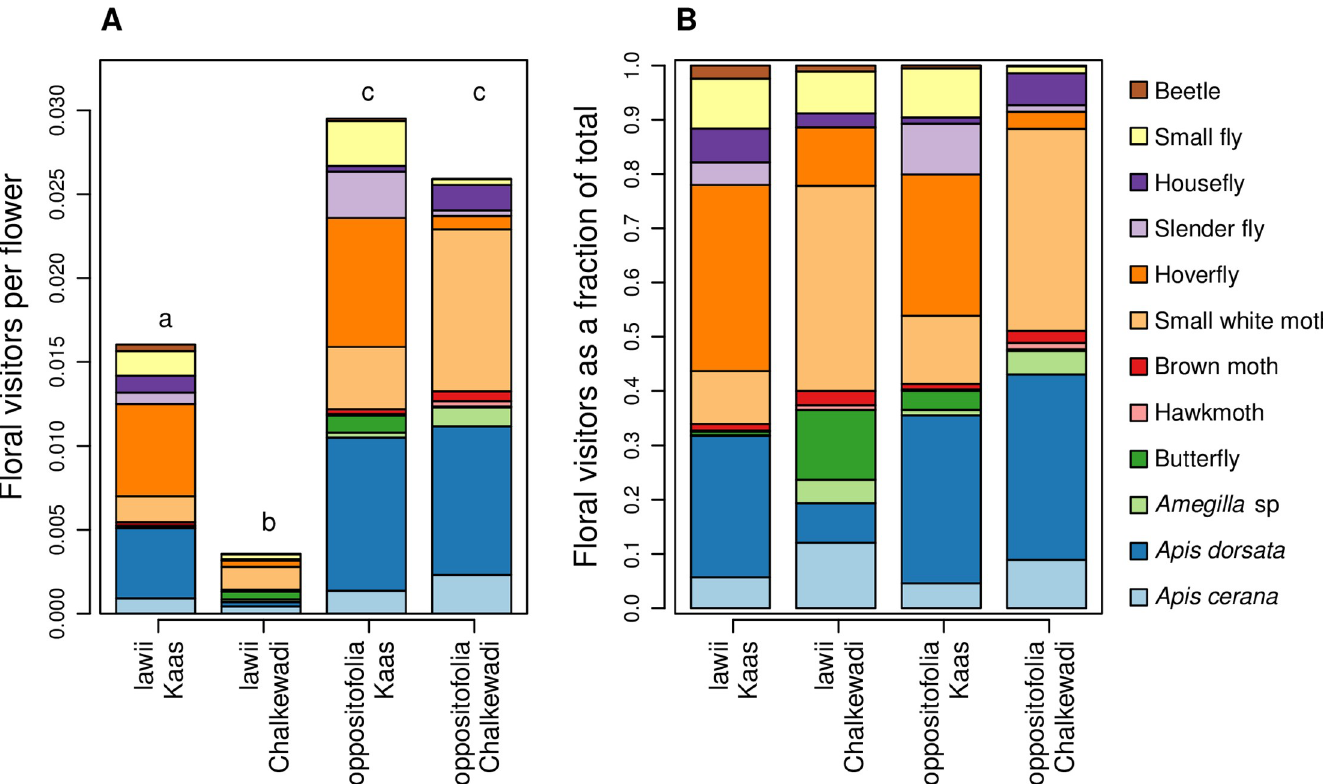
Fig 5. Floral visitors to Impatiens lawii and I . oppositifolia in Kaas and Chalkewadi plateaus. (A) The number of floral visitors belonging to the different putative pollinator groups. The number of floral visitors was normalized by the number of flowers observed. Lower case letters above the bars indicate significant differences (p < 0.05) in total floral visitation rates between plateaus and species based on Tukey’s post hoc tests. (B) Floral visitors depicted as the fraction of the total number of visitors.